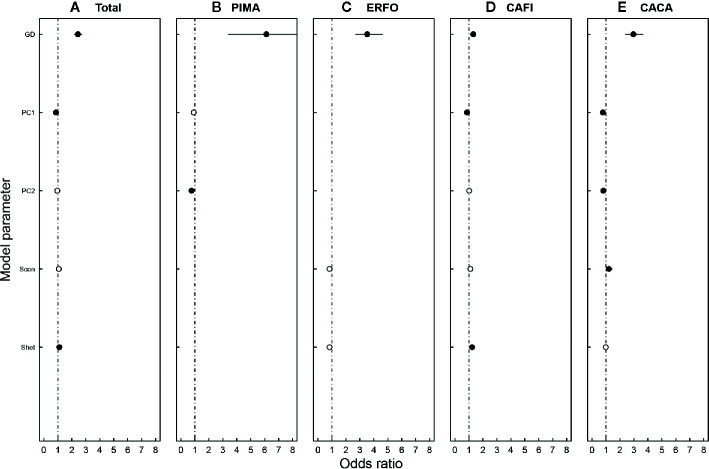
Odds ratios of variables on seedling survival by the best-fit models for (A) all species, (B)
P. massoniana (PIMA), (C)
E. fordii (ERFO), (D)
C. fissa (CAFI), and (E)
C. carlesii (CACA). Circles show odds ratios for each parameter, with 95% confidence limits indicated by horizontal lines. Black solid circles indicated significant effects (P < 0.05). Variable abbreviations: GD, ground diameter; Scon, sum of ground diameter for conspecific seedlings within 1 m radius; Shet, sum of ground diameter for heterospecific seedlings within 1 m radius.